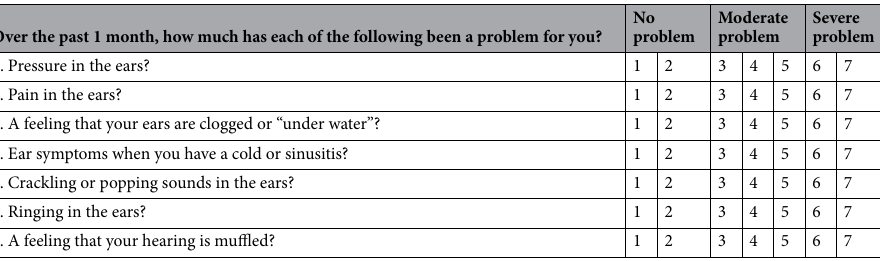
Table 1. The seven-item Eustachian tube dysfunction questionnaire 16 .